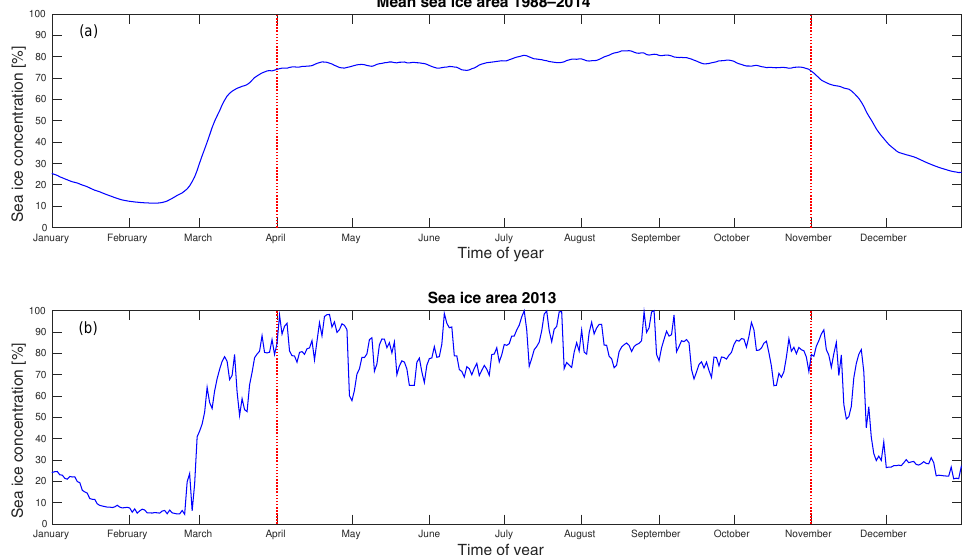
Figure 2. (a) Mean SIC within RSP north of the Laurie AWS from the region identified in Fig. 1. (b) SIC during 2013, highlighting day-to-day variability. Red dotted lines identify the period from April to October used in this study.